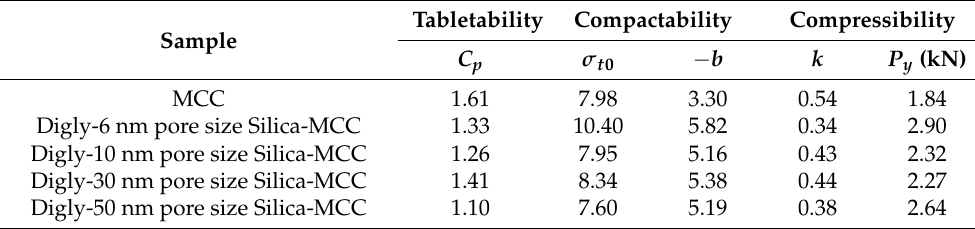
Table 2. Summary of the mechanical parameters obtained from the curve fitting of tabletability, compressibility, and compactability curves for diglycine–silica–MCC composites and bare MCC tablets ( C p is the tabletability parameter, σ t 0 is the tablet tensile strength at zero porosity, b is an empirical constant representing bonding capacity, k is the Heckle Coefficient, and P y is the yield pressure). Tabletability Compactability Sample